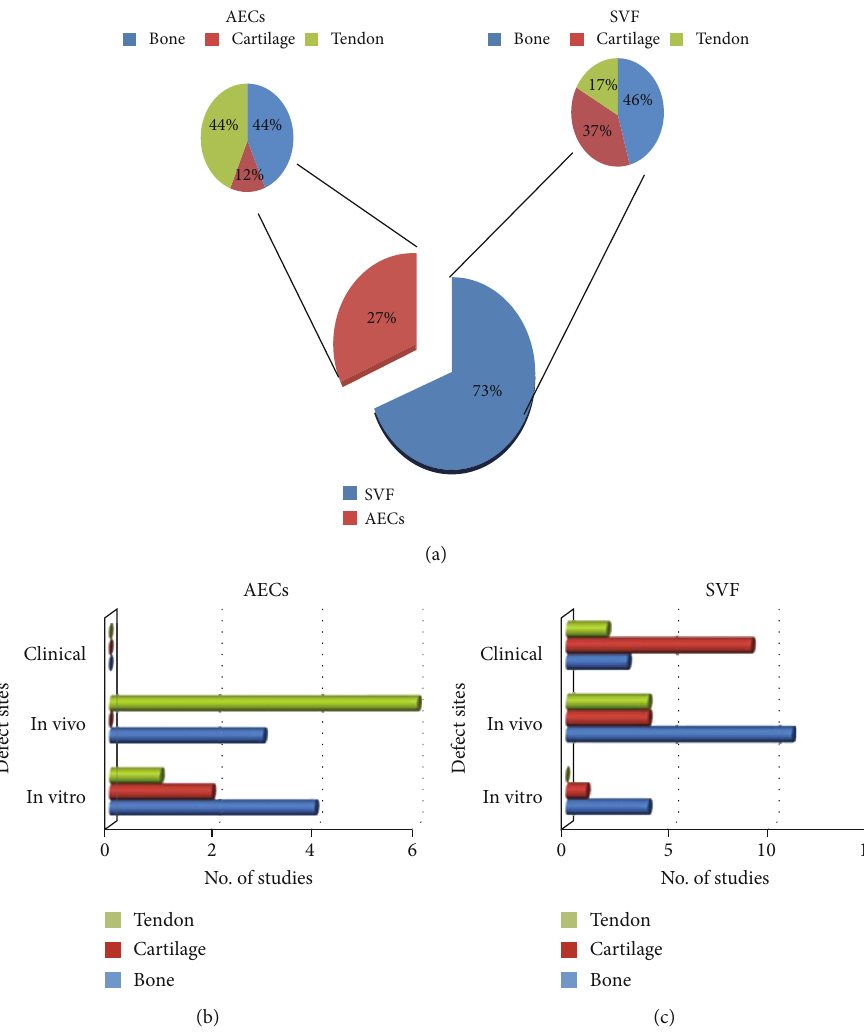
Figure 2: Amount of in vitro, in vivo, and clinical studies. (a) Pie chart of the percentages of the literature studies on SVF (blue: 73%) and AECs (red: 27%). In addition, the other two pie charts for each type of cell present the percentages of literature studies on bone (blue), cartilage (red), and tendon (green) regeneration. (b) Bar graph on the number of clinical, in vivo, and in vitro studies found in the literature, for the regeneration of bone (blue), cartilage (red), and tendon (green) by AECs. (c) Bar graph on the number of clinical, in vivo, and in vitro studies found in the literature, for the regeneration of bone (blue), cartilage (red), and tendon (green) by